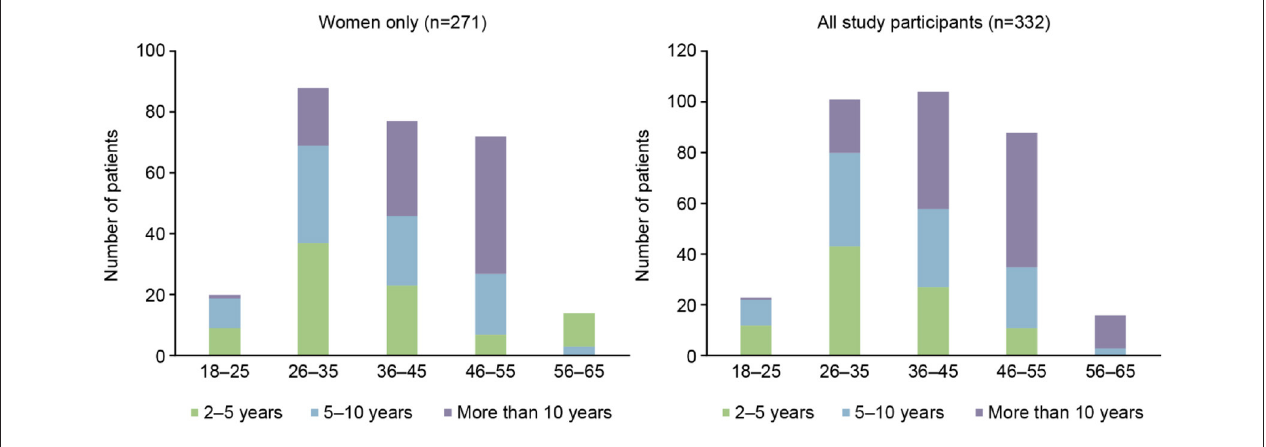
FIGURE 1 | Time since diagnosis of multiple sclerosis, by age group.